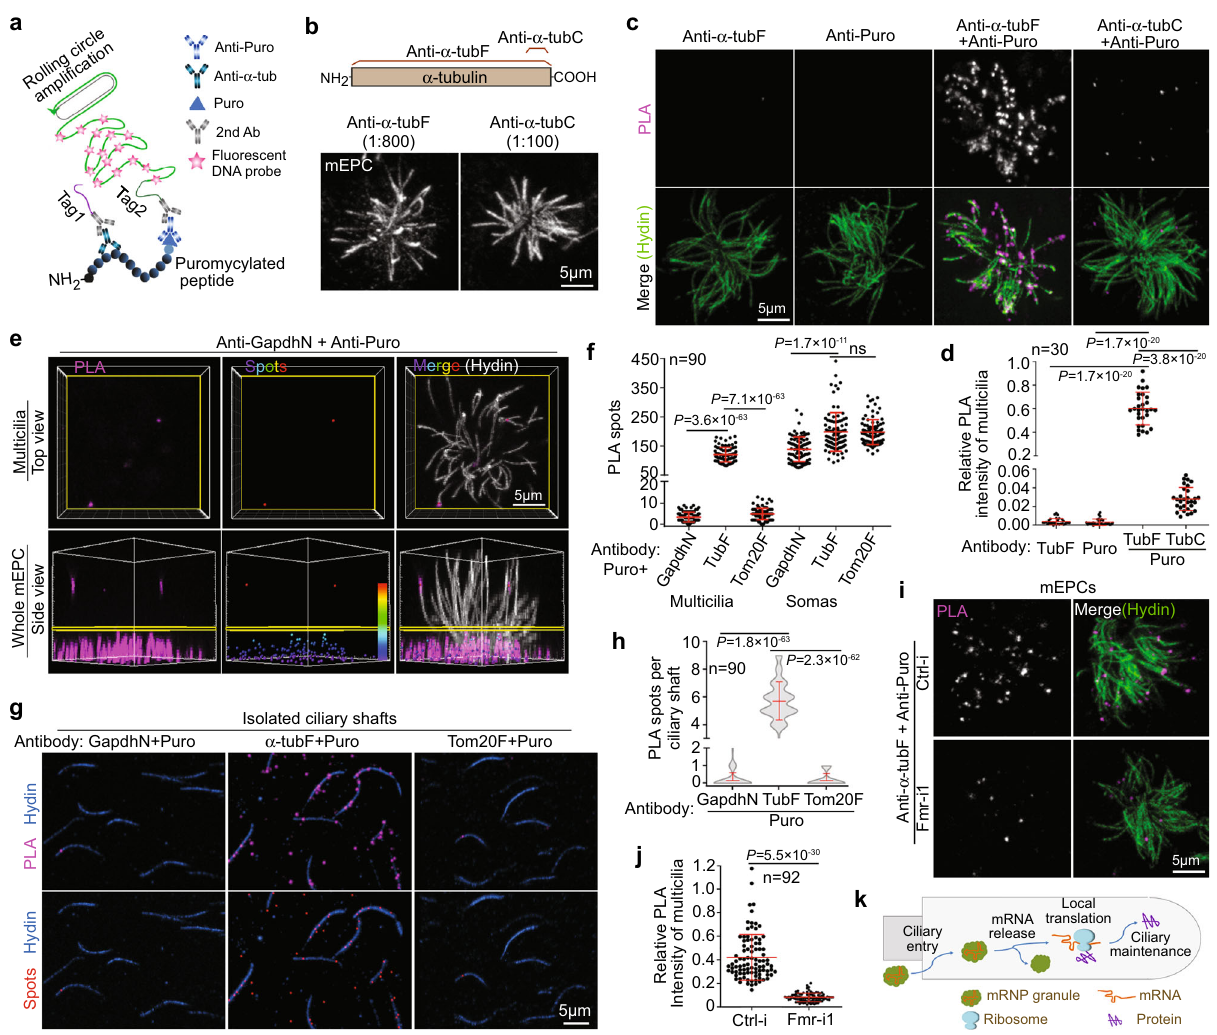
Fig. 8 Ependymal multicilia locally translate α -tubulin. Day 10 were used unless otherwise stated. Quanti fi cation results are presented as mean ± s.d. Those in ( f , h , j ) were pooled from three independent experiments. Two-tailed student ’ s t -test: ns, no signi fi cance. a Diagram illustrating PLA detection of a puromycylated α -tubulin peptide. The close positioning of two oligonucleotides (tag1 and tag2) enables ampli fi cation of approximately a thousand DNA repeats that can be visualized as a bright punctum through fl uorescent probe hybridization. b Rabbit antibodies against full-length (anti- α -tubF) and extreme C-terminal (anti- α -tubC) α -tubulin similarly decorated multiciliary axonemes at the indicated dilutions. c, d Multicilia contained puromycylated α - tubulin peptides. mEPCs were labeled with Puro for 10 min, followed by fi xation and PLA using the indicated antibodies ( c ). Hydin served as ciliary marker in the representative confocal images of PLA signals in multicilia ( d ). e, f Ependymal multicilia locally synthesized α -tubulin but not Gapdh and Tom20. Representative 3D-reconstructed images showing PLA signals from anti-GapdhN and anti-Puro antibodies as a negative control ( e ). The multicilia and soma regions are divided by the yellow plane. See Supplementary Fig. 4b for images from other antibody pairs. Statistical results ( f ) were scored from software-generated color-coded PLA spots 51 . As the z-depth of soma regions varied among cells, PLA spots in somas were normalized to the value in 2000 μ m 3 , which was close to the average volume covered by the confocal imaging. g, h Isolated ciliary shafts locally synthesized α -tubulin but not Gapdh and Tom20. Isolated ciliary shafts were labeled with Puro for 30 min, followed by PLA ( g , top panels). The PLA signals were converted to PLA spots ( g , bottom panels), PLA spots were scored from well-separated ciliary shafts ( h ). i, j Depletion of Fmrp markedly reduced ciliary PLA signals of puromycylated α - tubulin peptides. mEPCs transfected as in Fig. 4e were labeled with Puro for 10 min at day 9, followed by PLA. PLA signals in representative multicilia regions ( i ) and quanti fi cation results ( j ) are shown. k An illustration model, Fmrp-containing mRNP granules enter ciliary shaft and release their content mRNAs for local protein synthesis to support ciliary